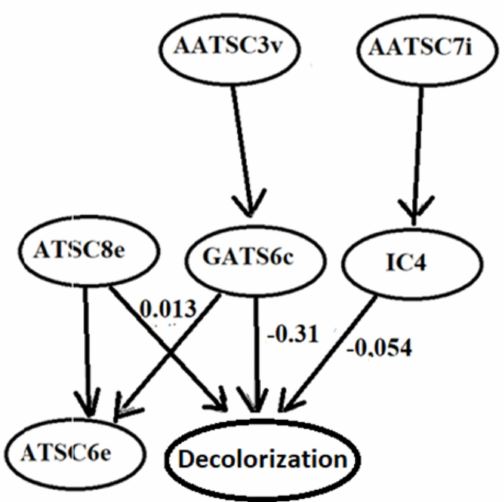
Figure 5. Directed acyclic graph (DAG) of the structural causal model of the rate of LPMO decol- orization rate. Depicted are linear path coefficients corresponding to the decolorization as direct (parental)